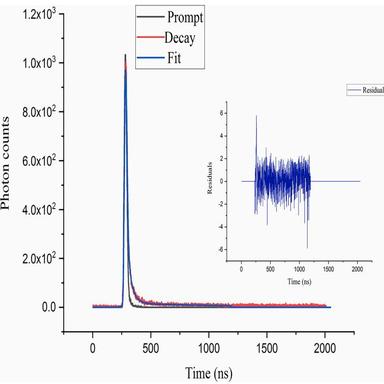
FLUORESCENCE LIFETIME CURVE